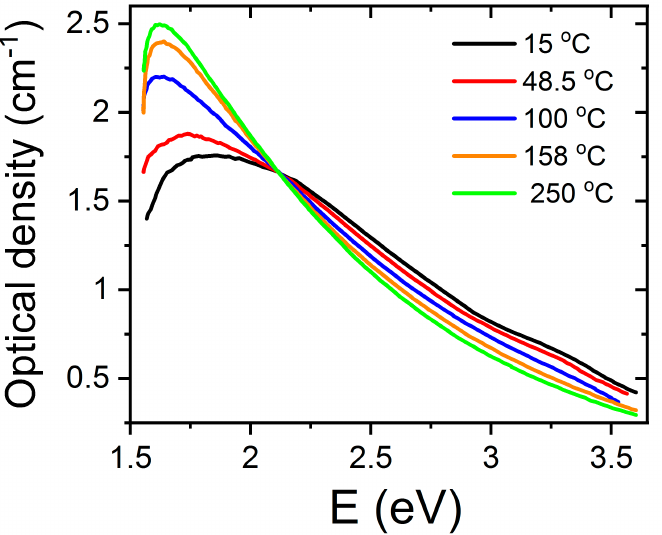
Figure 4. Effect of heating/cooling on the absorption spectra of congruent LiNbO 3 irradiated with high-energy electrons. This figure has been adapted from Hodgson et al. [32], Copyright (1987), with permission from Elsevier.